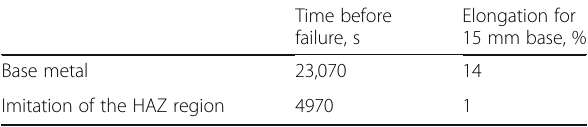
Table 10 Test results after deformation by stretching at a temperature of 600 °C of steel 10XN3MD